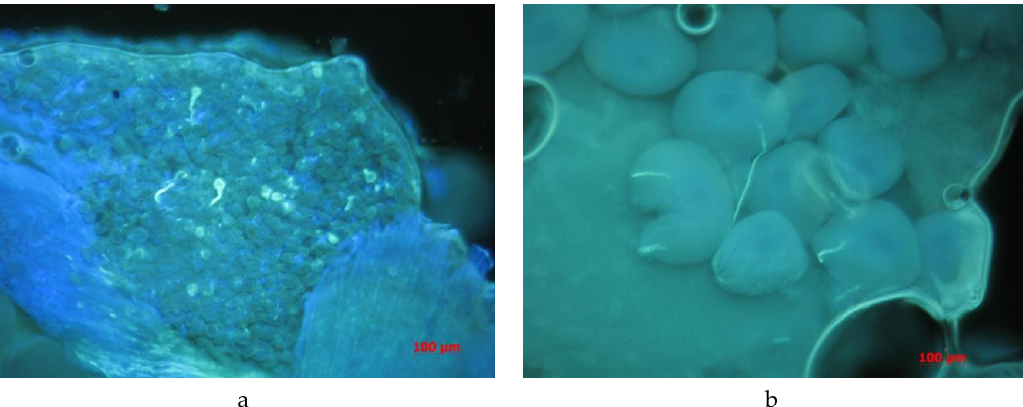
Figure 3. Germination of the pollen on stigmas ( a ) and fertilisation of ovules ( b ) of eggplant observed under fluorescence microscopy after Martin’s aniline blue fluorescence technique.